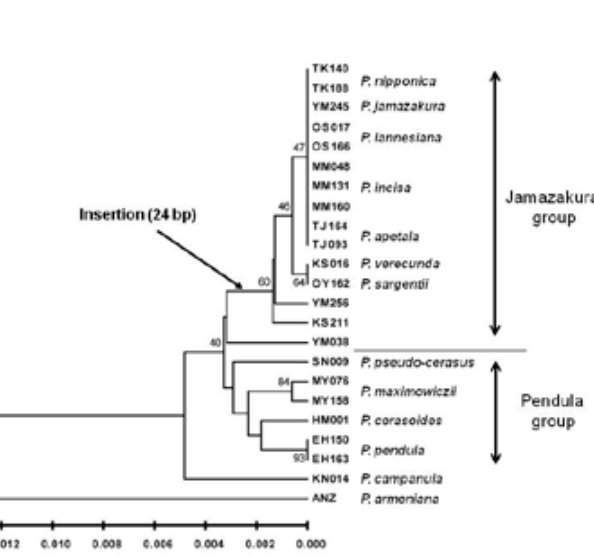
Fig. 3 - Phylogenetic UPGMA tree of the exon 20 sequences in the PolA1 genes from 22 individuals in nine Cerasus species. Indi- viduals used are listed in Table